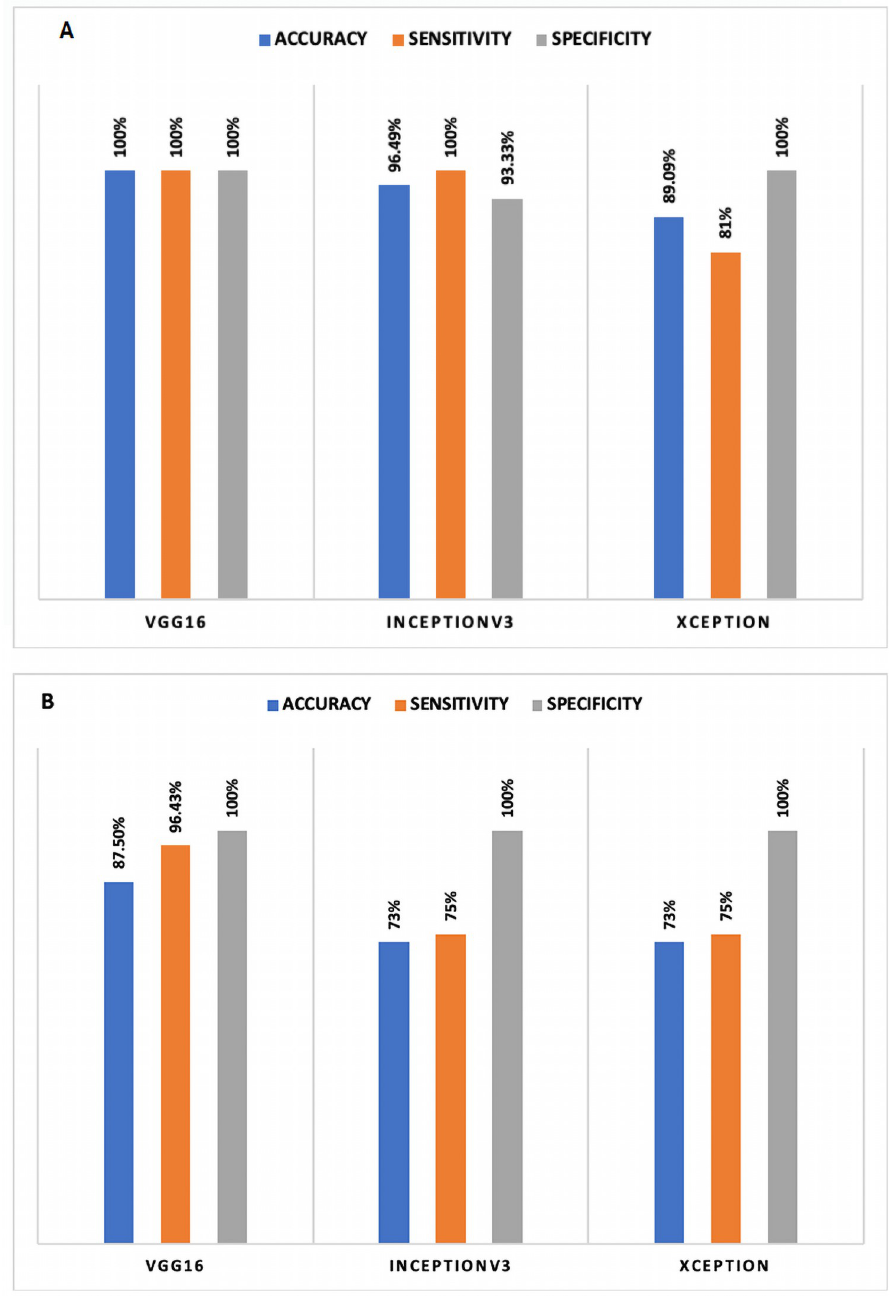
Fig 11. Comparison of accuracy achieved in selected models after fine-tune: (A) scenario I and (B) scenario II. radiographic images from various open-source data. The concept of knowledge transfer adopted by Ioannis et al. [58] for a similar objective as COVID-Net. They used 224 confirmed COVID-19, 700 pneumonia, and 504 normal radiology images in their study and achieved a 98.75% performance for the binary class and 93.48% for the multi-class classification. We